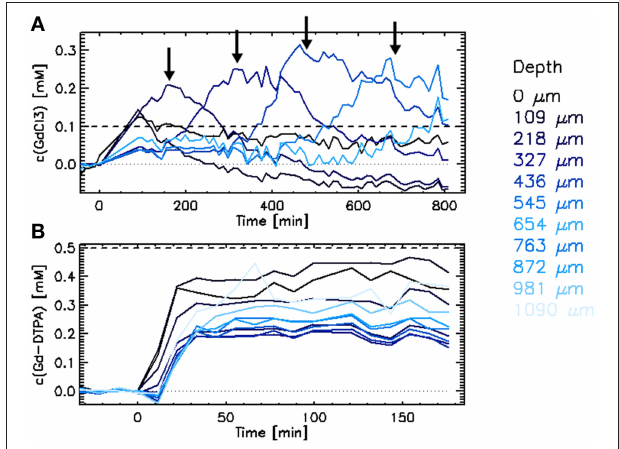
FIGURE 3 | Increase of Gd concentration in a single methanogenic granule upon exposure to (A) 0.1mmol · L − 1 GdCl 3 or (B) 0.5mmol · L − 1 [GdDTPA] 2 − solution. The arrows indicate the approximate time when the reactive barrier reached single